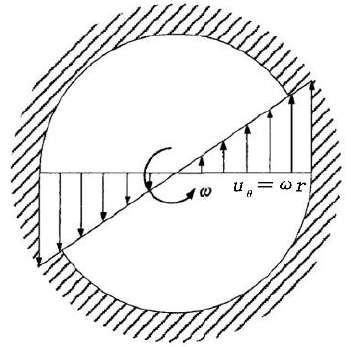
Figure 5. Schematic diagram of flow velocity of water in the vortex cover.